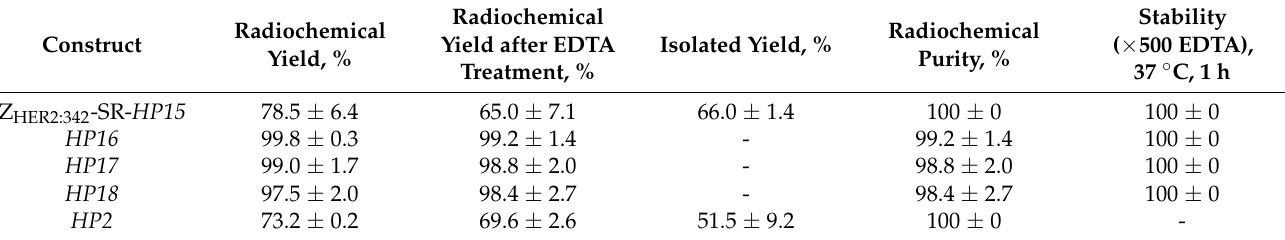
Table 3. 177 Lu-labeling of PNA-based probes and in vitro stability.